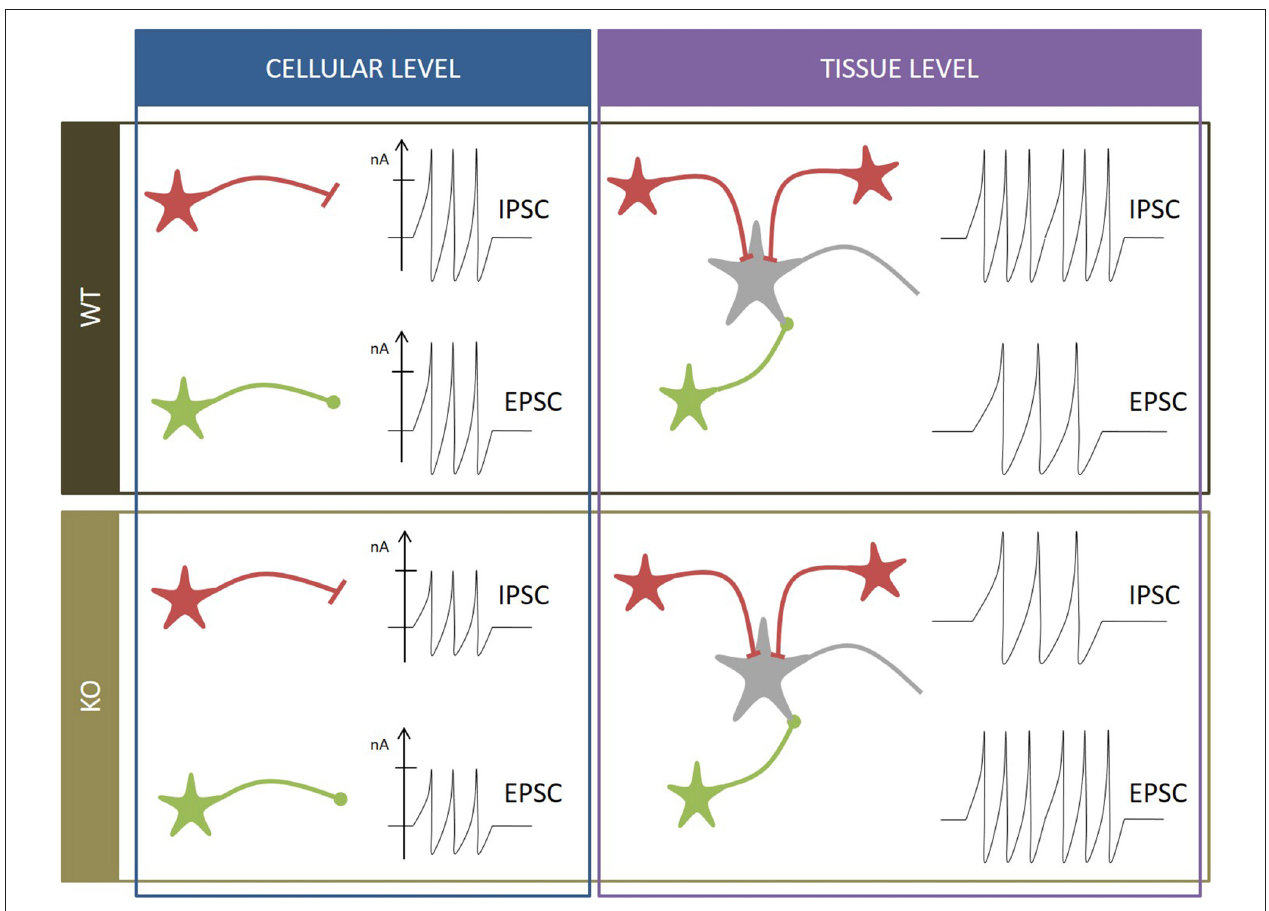
FIGURE 2 | Summary of neurophysiological observations. WT condition (black box): at cellular level (blue box), inhibitory postsynaptic currents (IPSC) and EPSC of inhibitory neurons (in red) and excitatory neurons (in green) display characteristic amplitudes and frequencies. At tissue level (purple box), the inhibitory frequency is higher than the excitatory frequency to moderate global input. SV2A KO condition (brown box): at cellular level (blue box), amplitudes of IPSC and EPSC are reduced. At tissue level (purple box), the excitatory frequency is higher than the inhibitory frequency, leading to seizure onset and